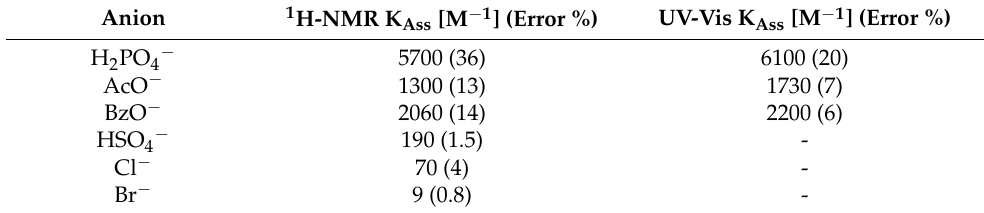
Table 1. Association constants of 10 with a series of TBA + salts of anions 1 .